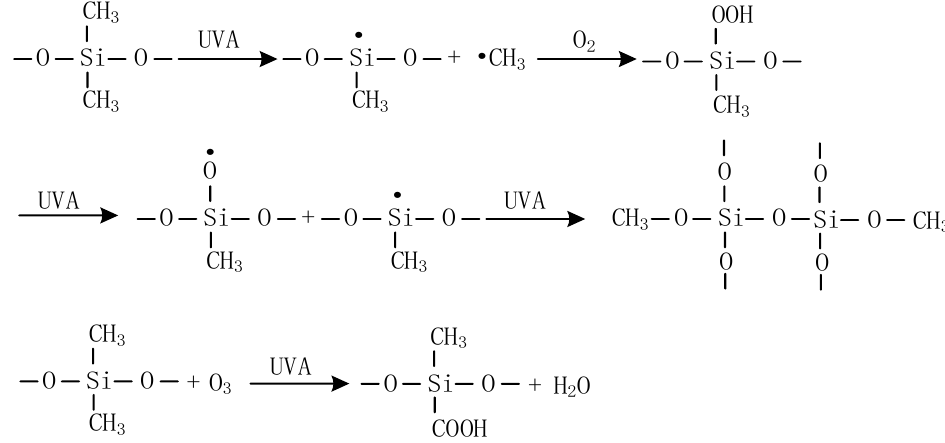
Figure 16. Proposed reactions of alicyclic epoxy resin during UV aging.